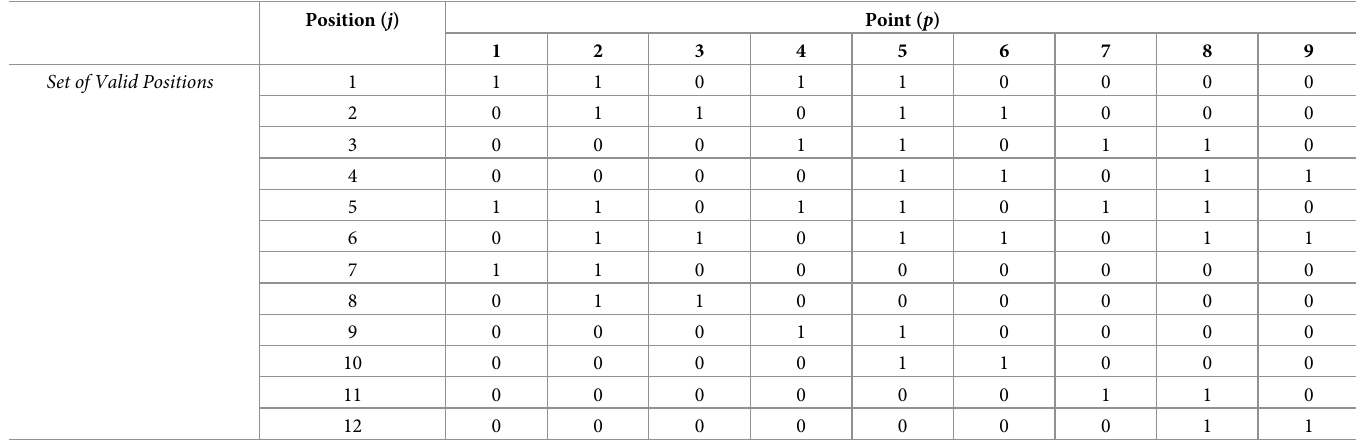
Table 1. Correspondence matrix C for items of Fig